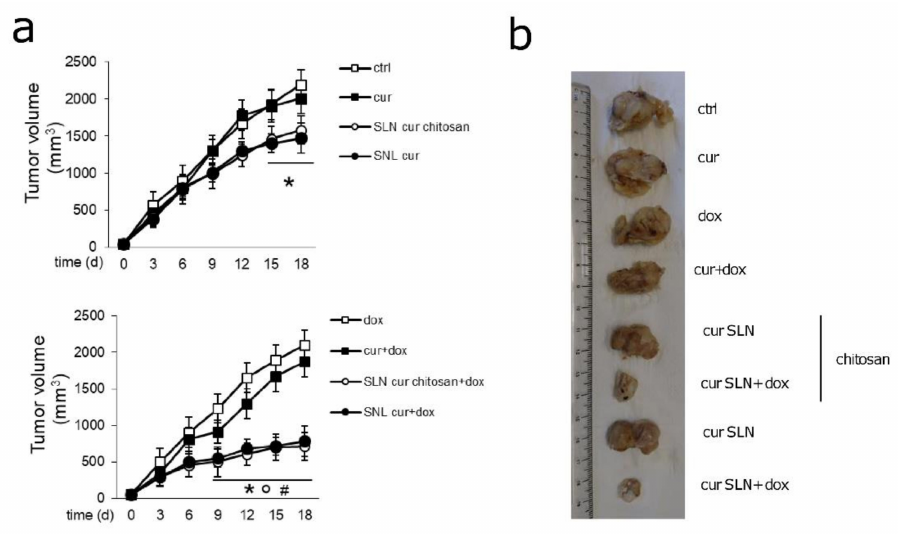
Figure 5. E ff ects of CURC-loaded SLNs against drug-resistant JC tumors. JC cells were orthotopically implanted into 6 week-old female balb / C mice. When the tumor reached the volume of 50 mm 3 , mice ( n = 8 mice / group) were randomized and treated, as reported in the following groups, on day 1, 7, and 14 after randomization: (1) Vehicle group (ctrl), treated with 200 µ L saline solution intravenously (i.v.); (2) CURC group (cur), treated with 5 mg / kg CURC, dissolved in 200 µ L water / 10% v / v DMSO solution i.v.; (3) doxorubicin group (dox), treated with 5 mg / kg doxorubicin, dissolved in 200 µ L water i.v.; (4) CURC + doxorubicin group (cur + dox), treated with 100 µ L of water / 10% v / v DMSO solution containing with 5 mg / kg CURC + 100 µ L water solution containing 5 mg / kg doxorubicin; (5) CURC-CS-SLN group, treated i.v. with 200 µ L of saline solution of the indicated SLNs containing 5 mg / kg CURC; (6) CURC-SLN group, treated i.v. with 100 µ L of saline solution of the indicated SLNs containing 5 mg / kg CURC + 100 µ L water solution containing 5 mg / kg doxorubicin; (7) CURC-SLN group, treated i.v. with 100 µ L of saline solution of the indicated SLNs containing 5 mg / kg CURC; and (8) uncoated / CURC-loaded SLN + doxorubicin group (cur SLN + dox), treated i.v with 200 µ L of saline solution of the indicated SLNs containing 5 mg / kg CURC + 100 µ L water solution containing 5 mg / kg doxorubicin. ( a ) Tumor growth was monitored daily by caliper measurements. Data are presented as means ± SD. * p < 0.01: vs. ctrl; * p < 0.001: vs. dox; # p < 0.001: vs. cur. ( b ) Photographs of representative tumors of each